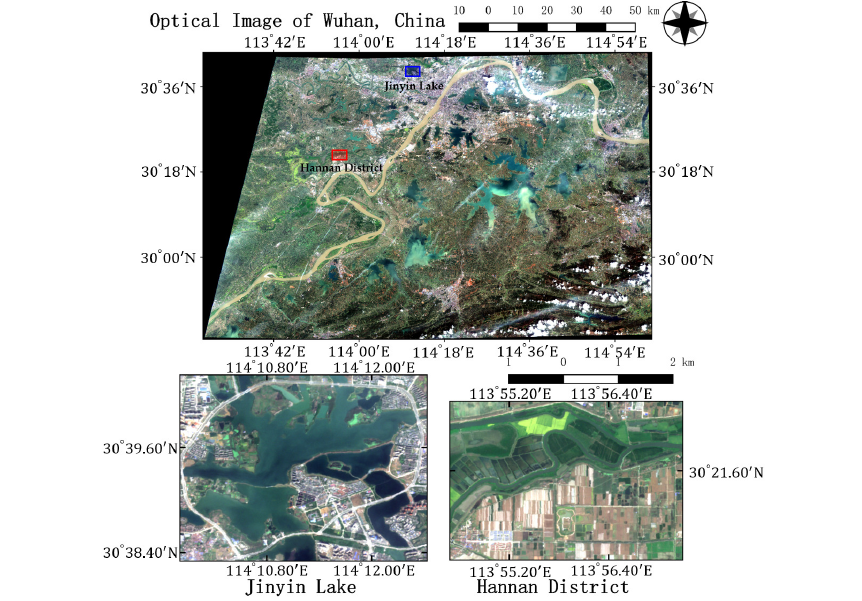
Figure 3. Geographic extent of the study area and Pauli RGB images of the GF-3 PolSAR data (left: image #1, right: image #2). The red rectangles indicate the locations of the sub-images that are cropped.